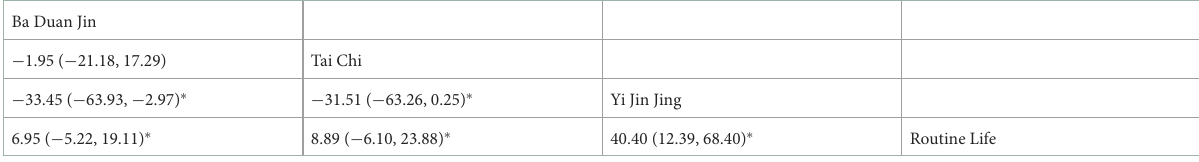
TABLE 4 Results of the network meta-analysis (SMD vs. 95% CI) of the effects of different traditional exercises on MFES in the